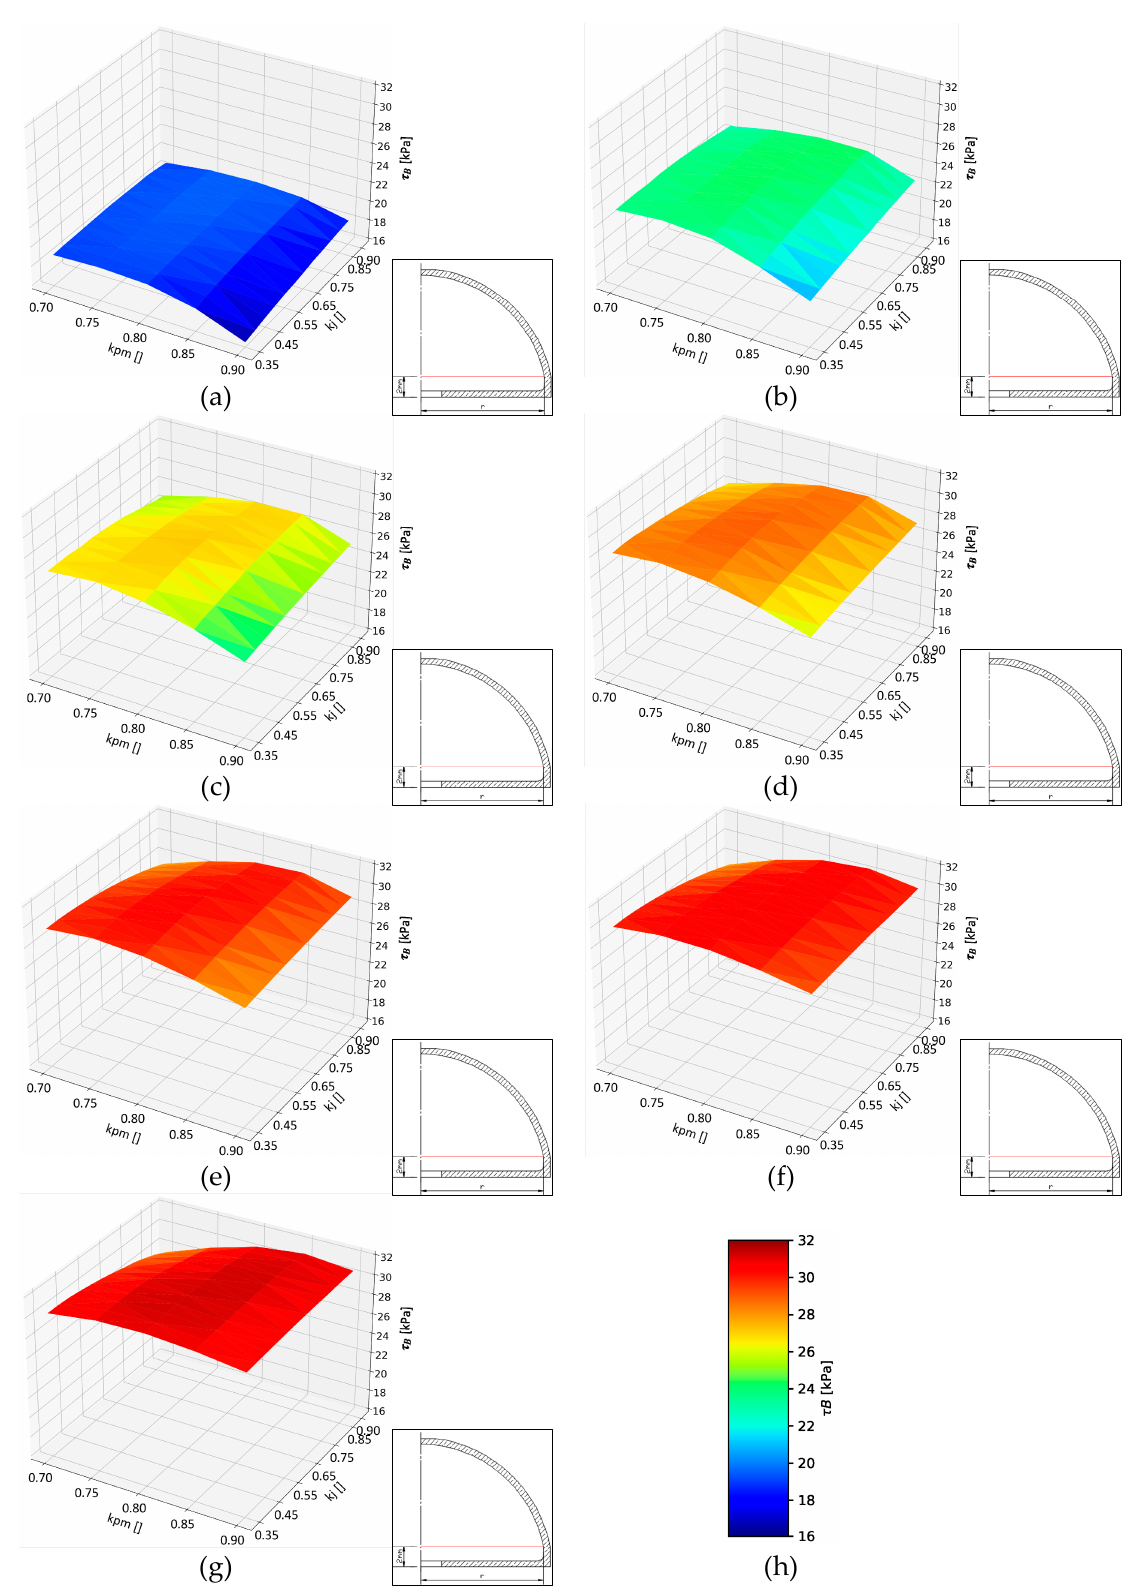
Figure 9. Average τ B shear stress distributions for Instance 1 with z = 1 and gm equal to: ( a ) 2 mm; ( b ) 3 mm; ( c ) 4 mm; ( d ) 5 mm; ( e ) 6 mm; ( f ) 7 mm; ( g ) 8 mm; ( h ) color scale indicating shear stress value.